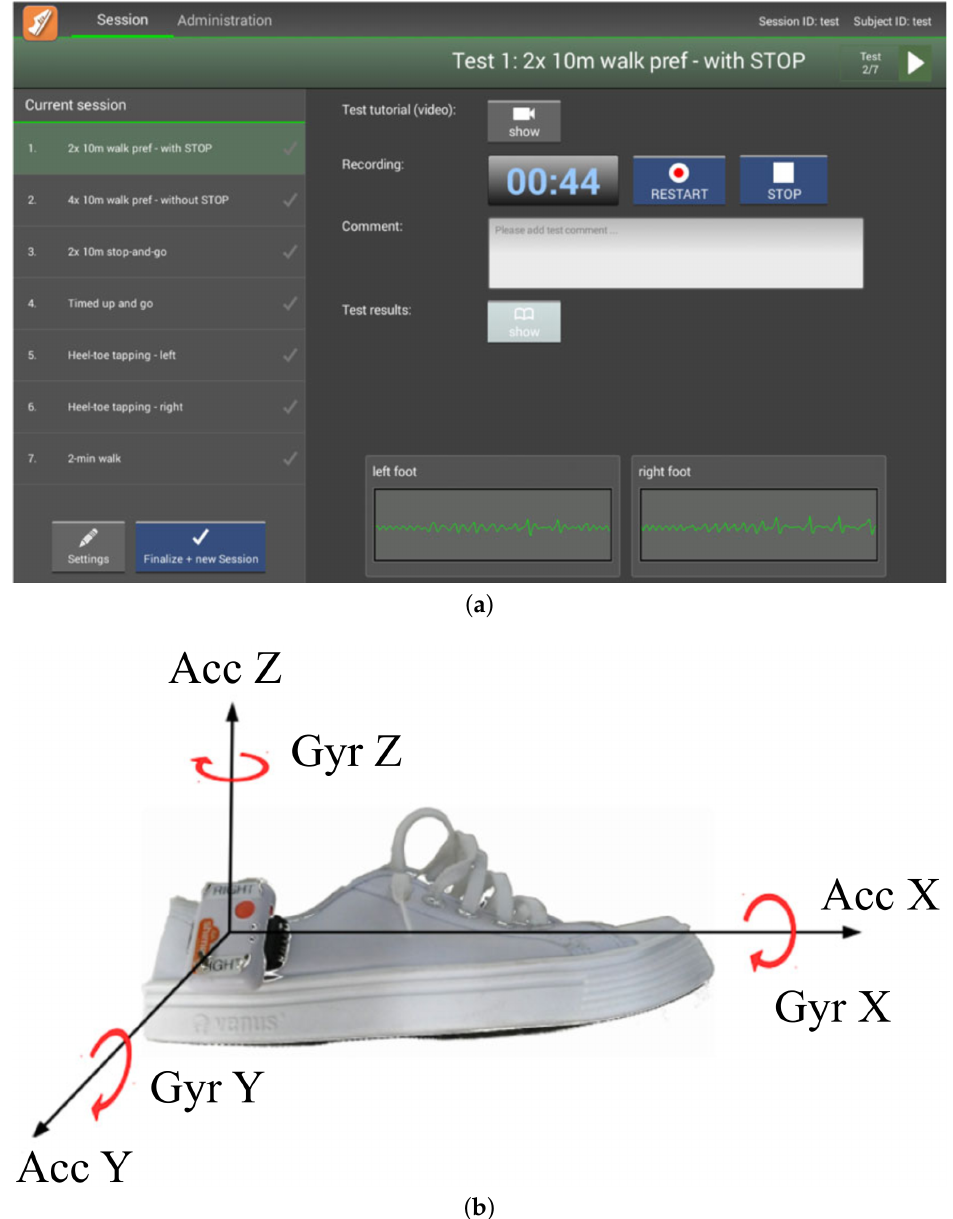
Figure 2. ( a ) Interface of the eGait software, ( b ) Location of the eGait sensor in the